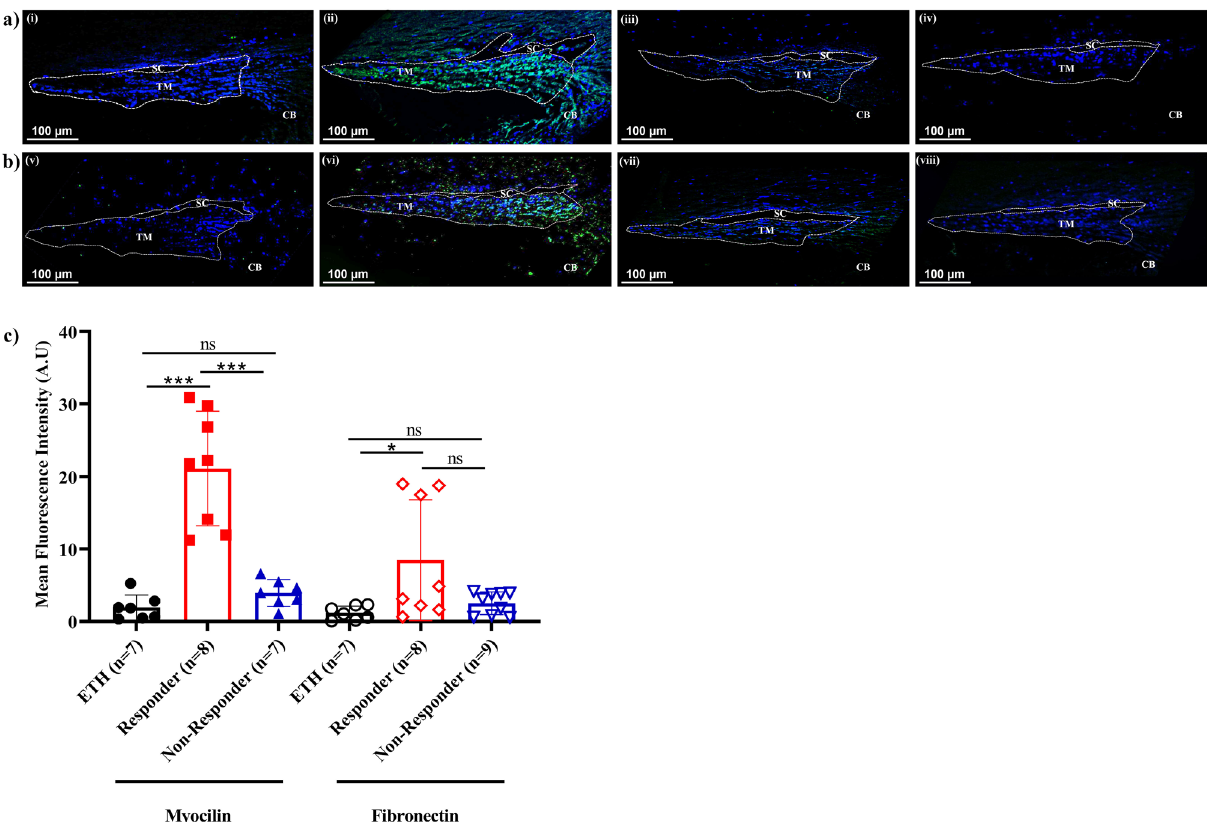
Figure 3. Effect of DEX on Myocilin and Fibronectin Expression in HOCAS-TM Tissues. Representative confocal images of ( a ) myocilin and ( b ) fibronectin expression (green) in ETH (Vehicle)-treated (i,v), DEX- responder (ii, vi), non-responder (iii, vii) eyes and negative control (no primary antibody) (iv, viii), DAPI (Blue): Nuclear counterstain. ( c ) Quantification of mean fluorescence intensity of myocilin and fibronectin expression in HOCAS-TM tissues of ETH- treated (n = 7), DEX-responder (n = 7) and non-responder eyes (7–9). Fluorescence images of five consecutive sections of TM from DEX treated and vehicle control eyes were analyzed and quantified for myocilin and fibronectin expression (green) in TM using Image J software [https :// image j.nih.gov/ij/]. A significant increase in mean fluorescence intensity of myocilin ( p = 0.0002) and fibronectin ( p = 0.04) was found in GC responder eyes as compared to vehicle-treated eyes. Data are shown as mean ± SEM. * p < 0.05; **** p < 0.00001; Un-paired t test. TM-Trabecular meshwork; SC-Schlemm’s canal and CB-Ciliary